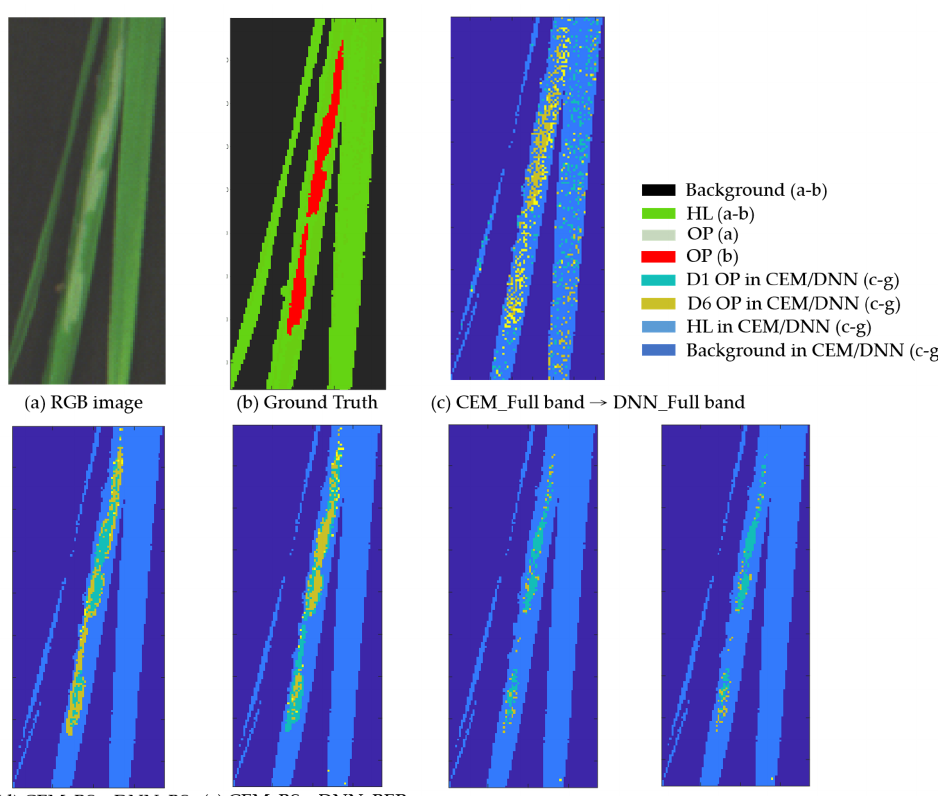
Figure 10. Prediction of spectral information from unknown rice sample: ( a ) true-color image, ( b ) Ground Truth, ( c ) CEM_Full-band → DNN_Full-band, ( d ) CEM_band selection → DNN_band selection, ( e ) CEM_band selection → DNN_BEP, ( f ) CEM_BEP → DNN_band selection, and ( g ) CEM_BEP →